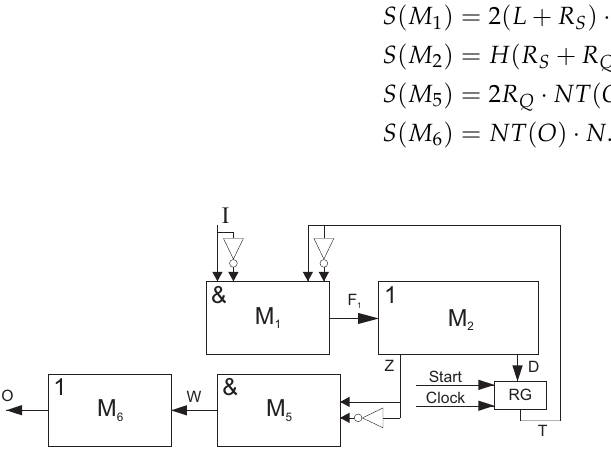
Figure 12. Structural diagram of PY Mealy FSM.